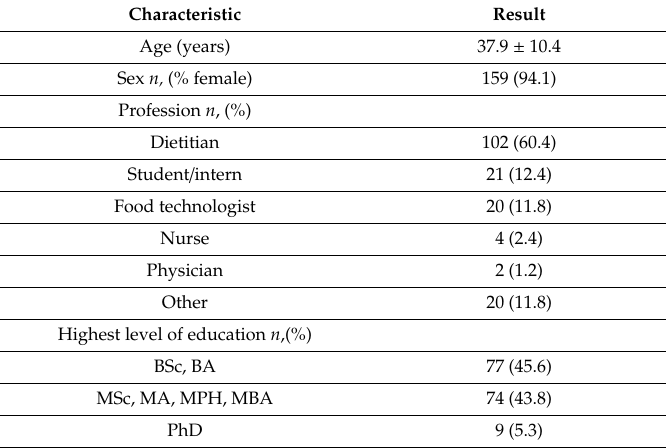
Table 1. Characteristics of survey participants ( n =